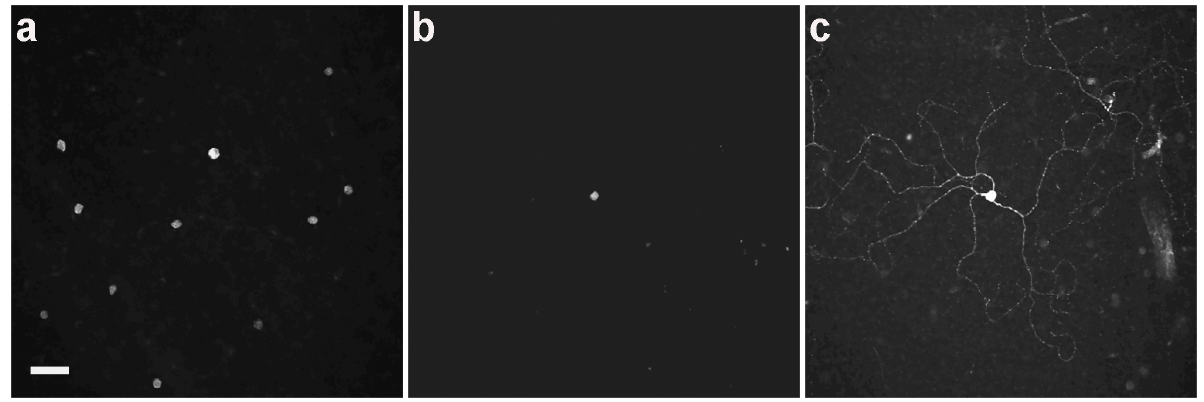
Figure 5. Displaced ganglion cells in the rat retina. (a) RBPMS immunostaining shows numerous displaced ganglion cells in the control eye. (b) The majority of the RBPMS-positive cells are lost 21 days after axotomy. The surviving displaced ganglion cells (b) correspond to M1 ganglion cells (c). Scale bar=50 m m.